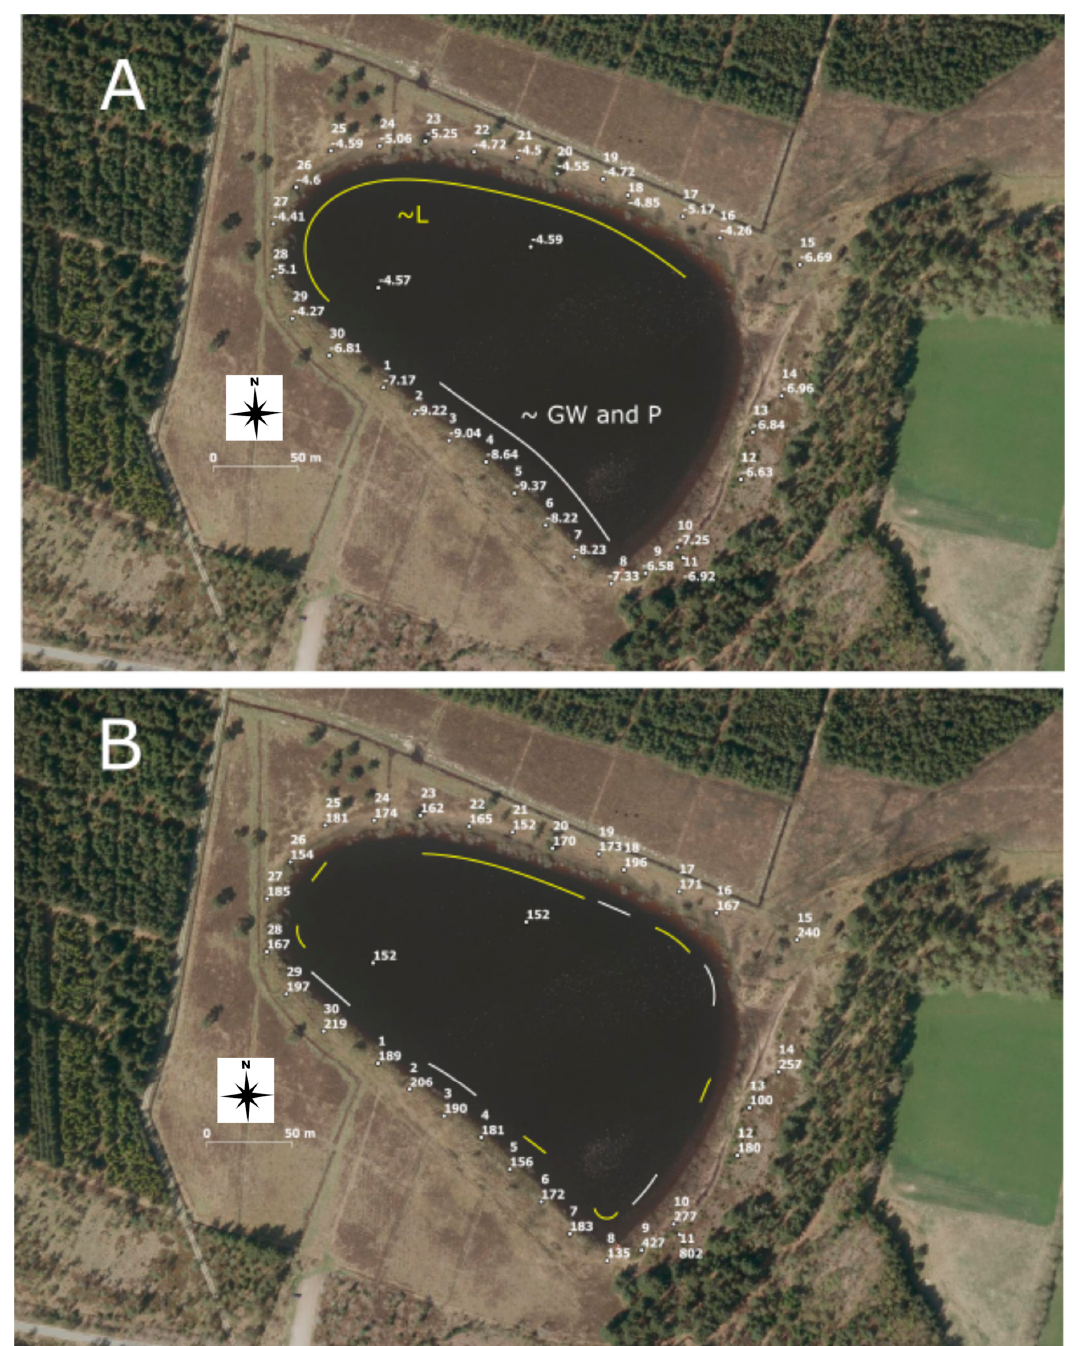
Figure 6. Measured ( A ) δ 18 O and ( B ) electrical conductivity (EC) at the 30 sampling locations around the lake and two locations in the lake (sampled February 2016). The upper and lower number are the location and value, respectively. White and yellow (broken) lines indicate where the groundwater samples could represent groundwater/precipitation (GW and P) or lake water (L), respectively.